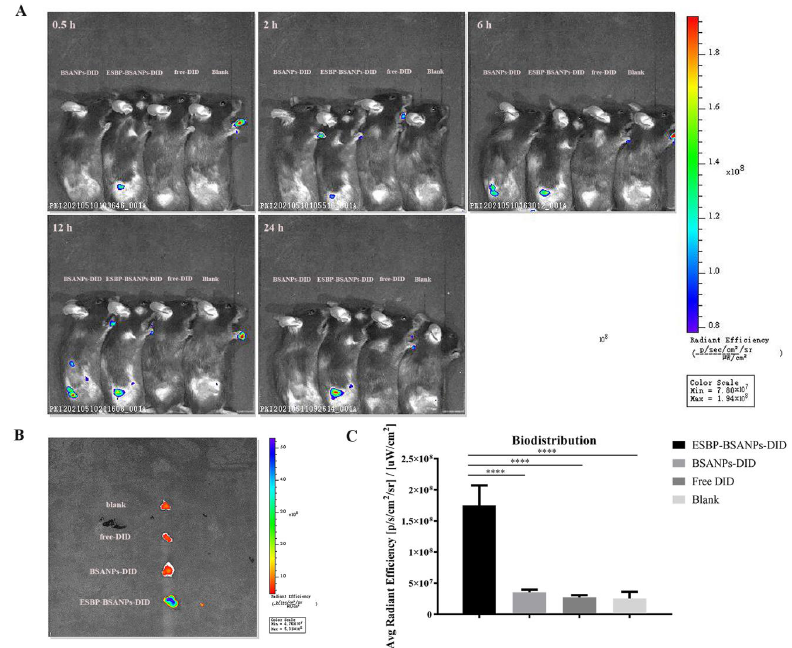
Figure 4. In vivo tumor targeting and drug delivery in mice tumor-bearing model: ( A ) fluorescence distribution in vivo at 0.5 h, 2 h, 6 h, 12 h and 24 h; ( B , C ) subcutaneous tumors were removed